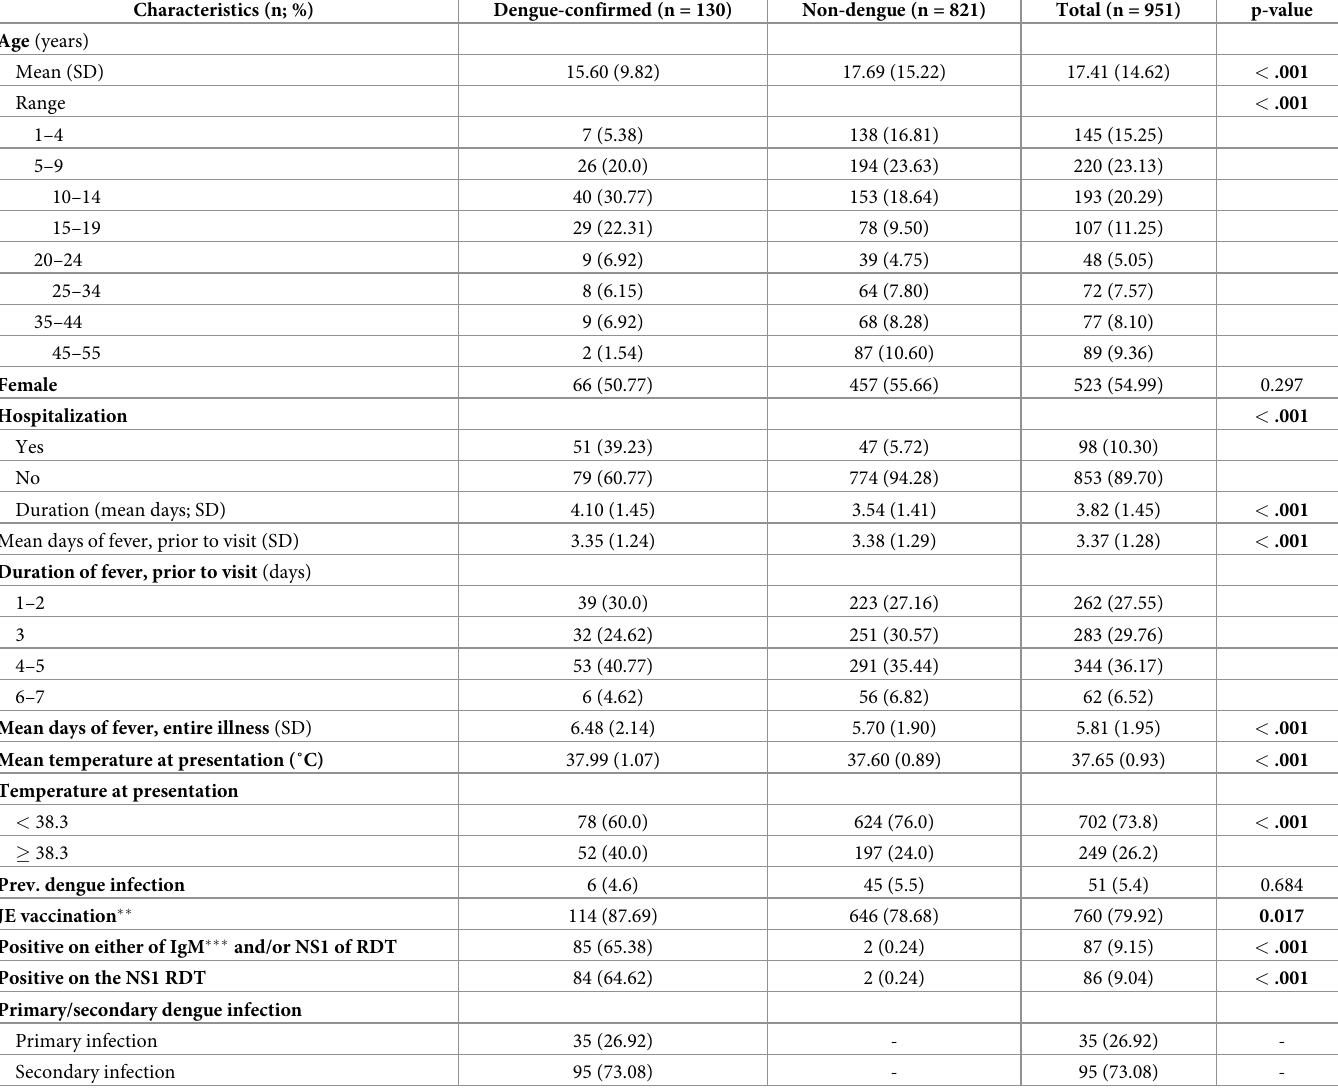
Table 1. Demographic and clinical characteristics of the dengue-confirmed and non-dengue patients as well as total enrolled study patients with non-localizing febrile illness from the health facility-based fever surveillance established in Bang Phae district, Ratchaburi province, Thailand in 2011–2016. Characteristics (n;